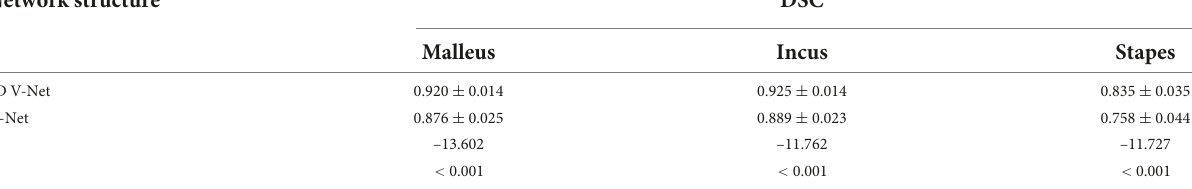
TABLE 3 Comparison of DSC between automatic segmentation and manual segmentation under two neural networks. Network structure